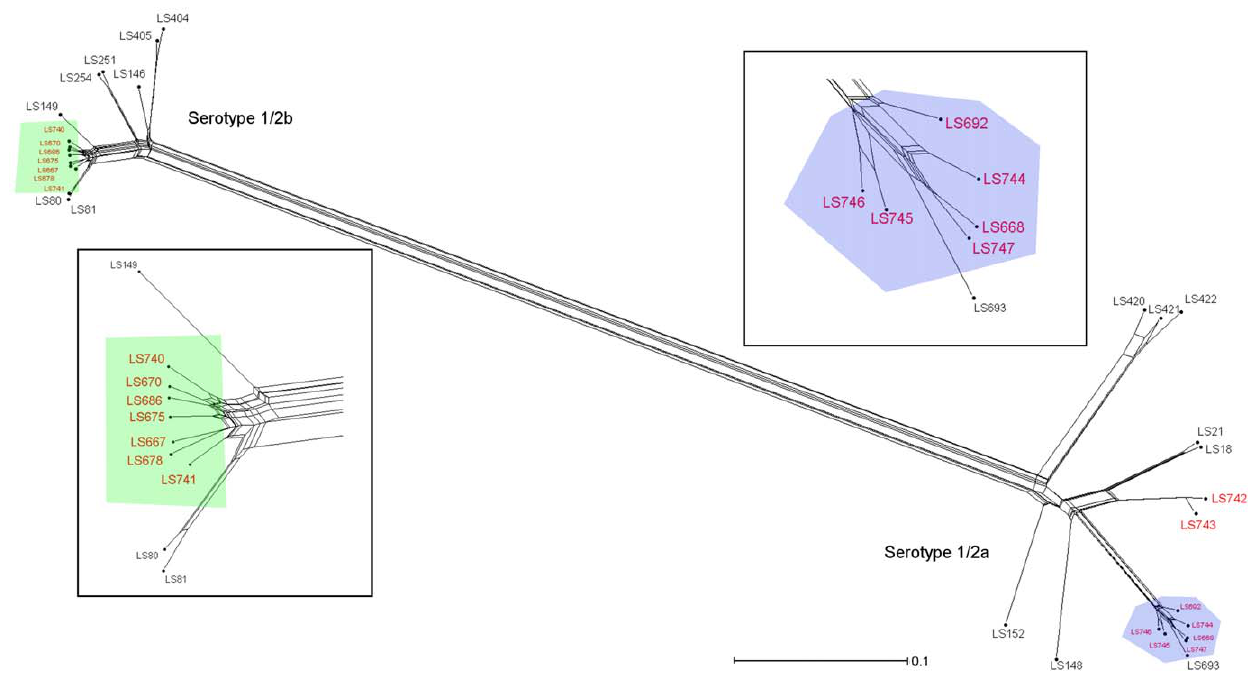
Figure 3. Relatedness analysis of the compatible parsimony informative genes from the 15 cantaloupe associated outbreak isolates, a shrimp isolate (LS693) and 15 L.monocytogenes isolates from several unrelated listeriosis episodes/outbreaks. The tree was generated from the concatenated gene contents using neighbor joining with the uncorrected p distance. The numbers in red color indicate the cantaloupe associated outbreak and the shrimp isolates. The boxes indicate the close-up portions of the cantaloupe outbreak strains (green; serotype 1/2b and blue; serotype 1/2a). Scale bar represents number of gene differences (present or absent) per gene site. The Roman numerals represent the PFGE pattern